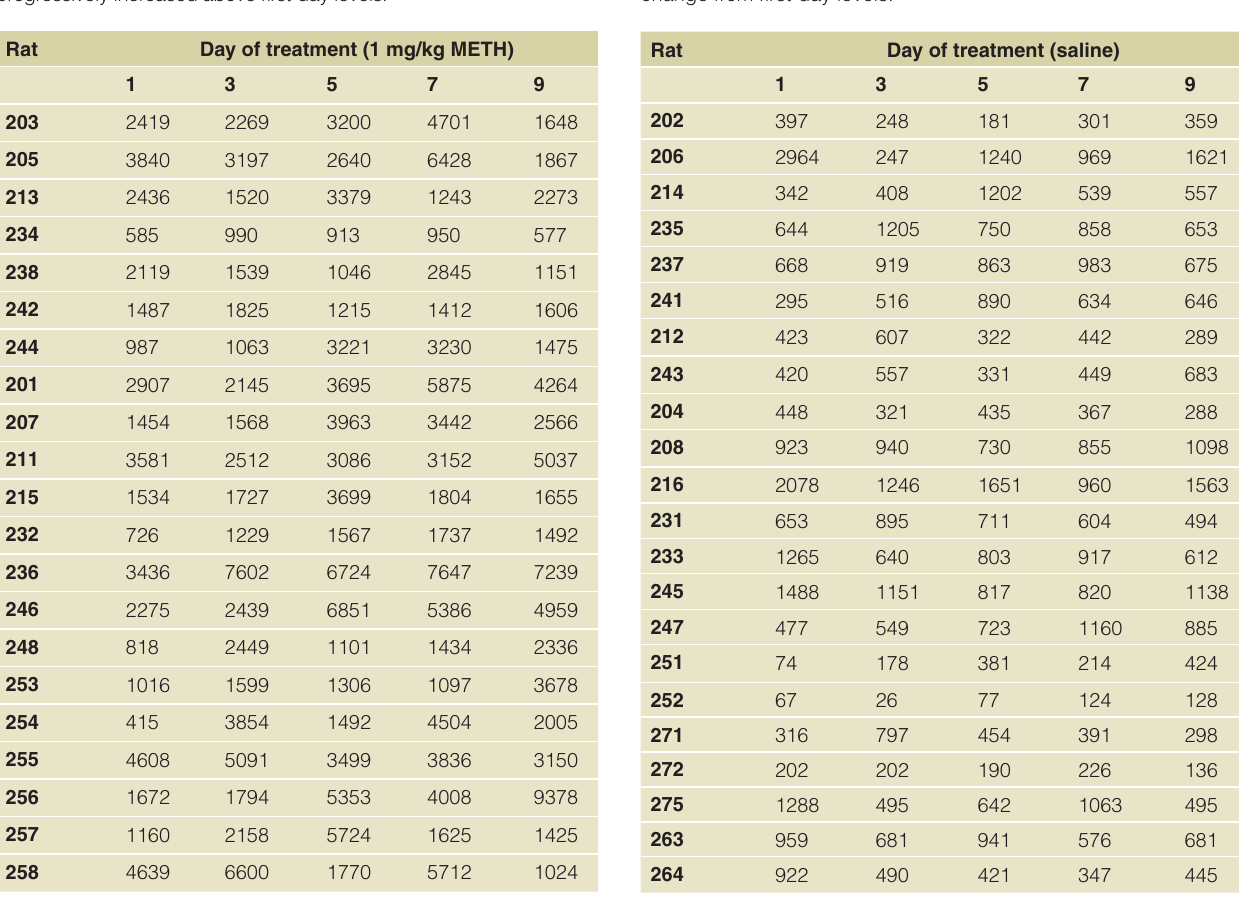
Table S1. CDPPB experiment – locomotor response (total quarter turns over 90 min) after chronic METH treatments. In locomotor sessions prior to mGluR5-targeted treatment, rats were chronically given 1 mg/kg METH i.p. In this experiment, the reported quarter turns progressively increased above first-day levels.